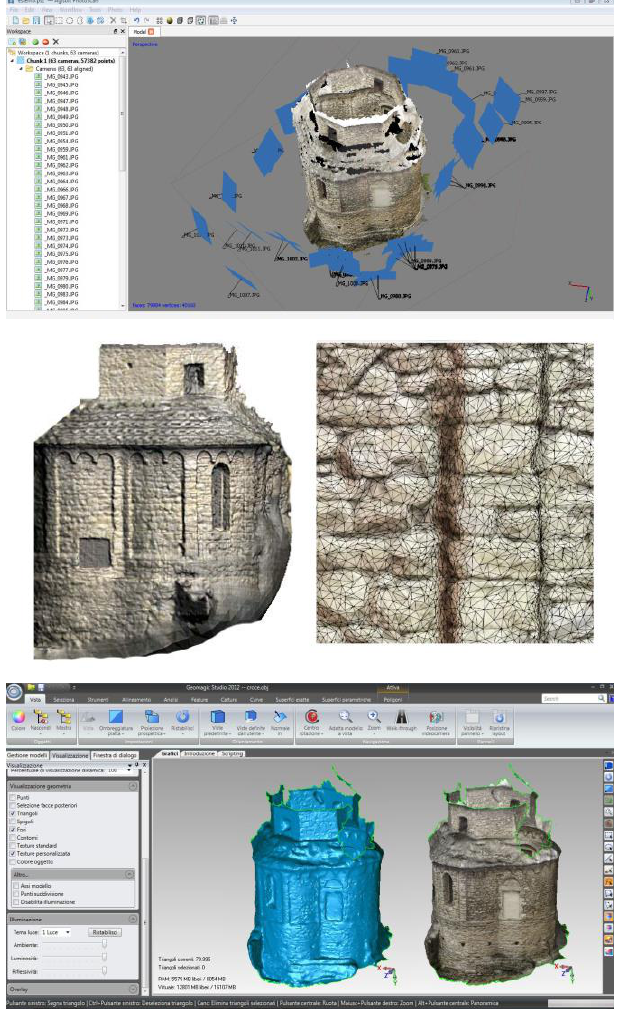
Fig. 5 The image-based model